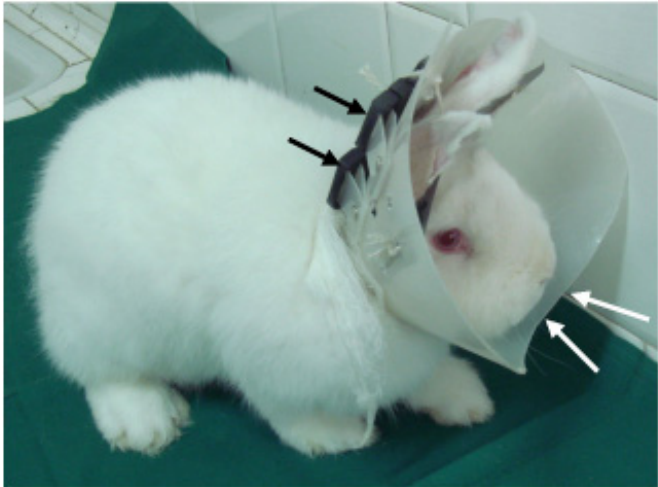
FIGURE 2 – Photograph of a rabbit wearing the collar, showing the position of the fasteners on the back of the neck (black arrows) and the half-moon CUT coinciding with the mouth of the animal (white arrows), placed opposite the